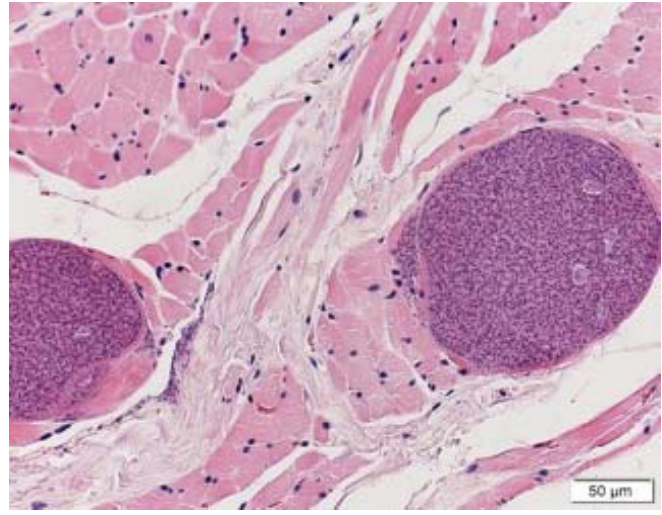
Figure 5. Section of tongue containing presumptive sarcocysts. Photo: L. Johnson.